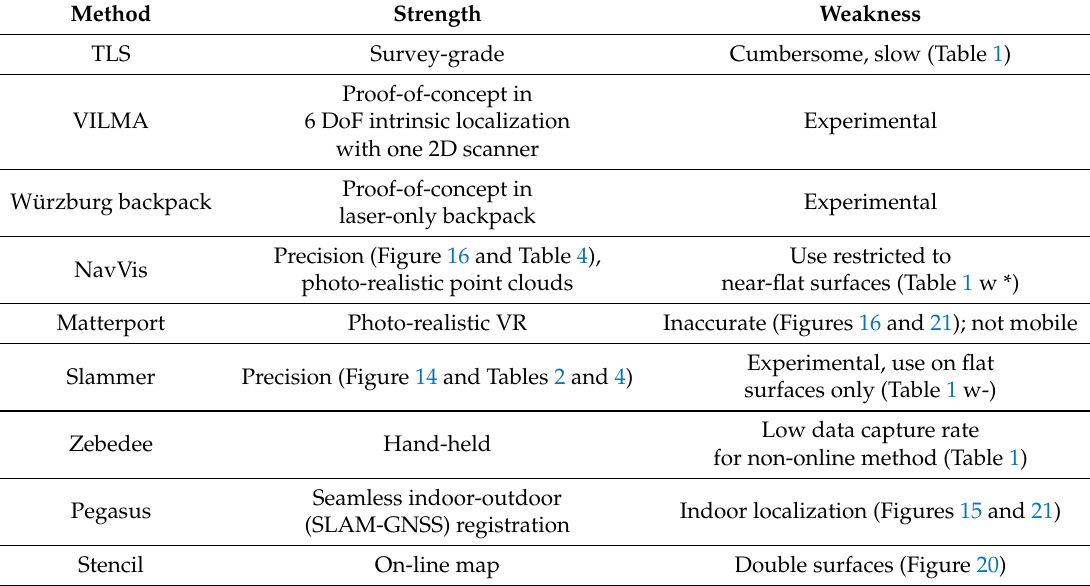
Table 5. Summarized strengths and weaknesses for each studied